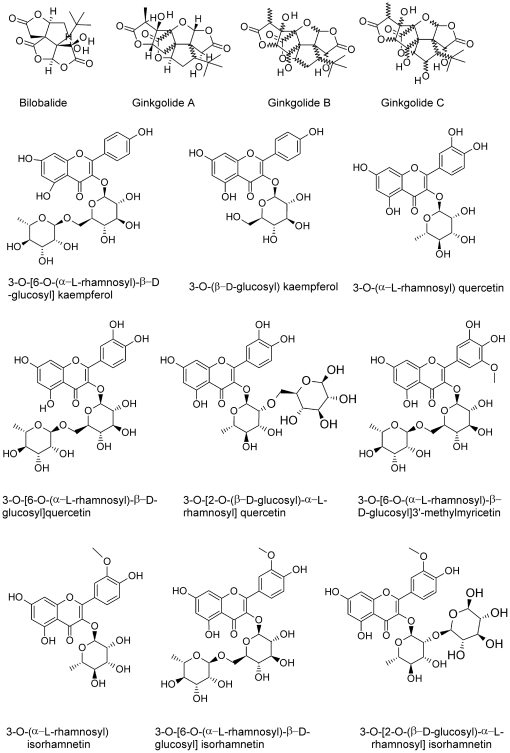
Structure formulae of the main representative G. biloba compounds.